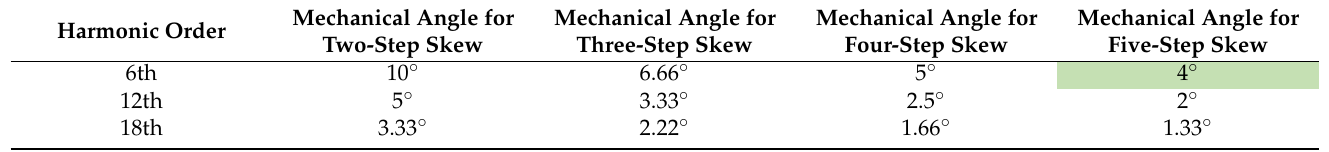
Table 10. Skew angle to reduce a specific harmonic component of the electromagnetic